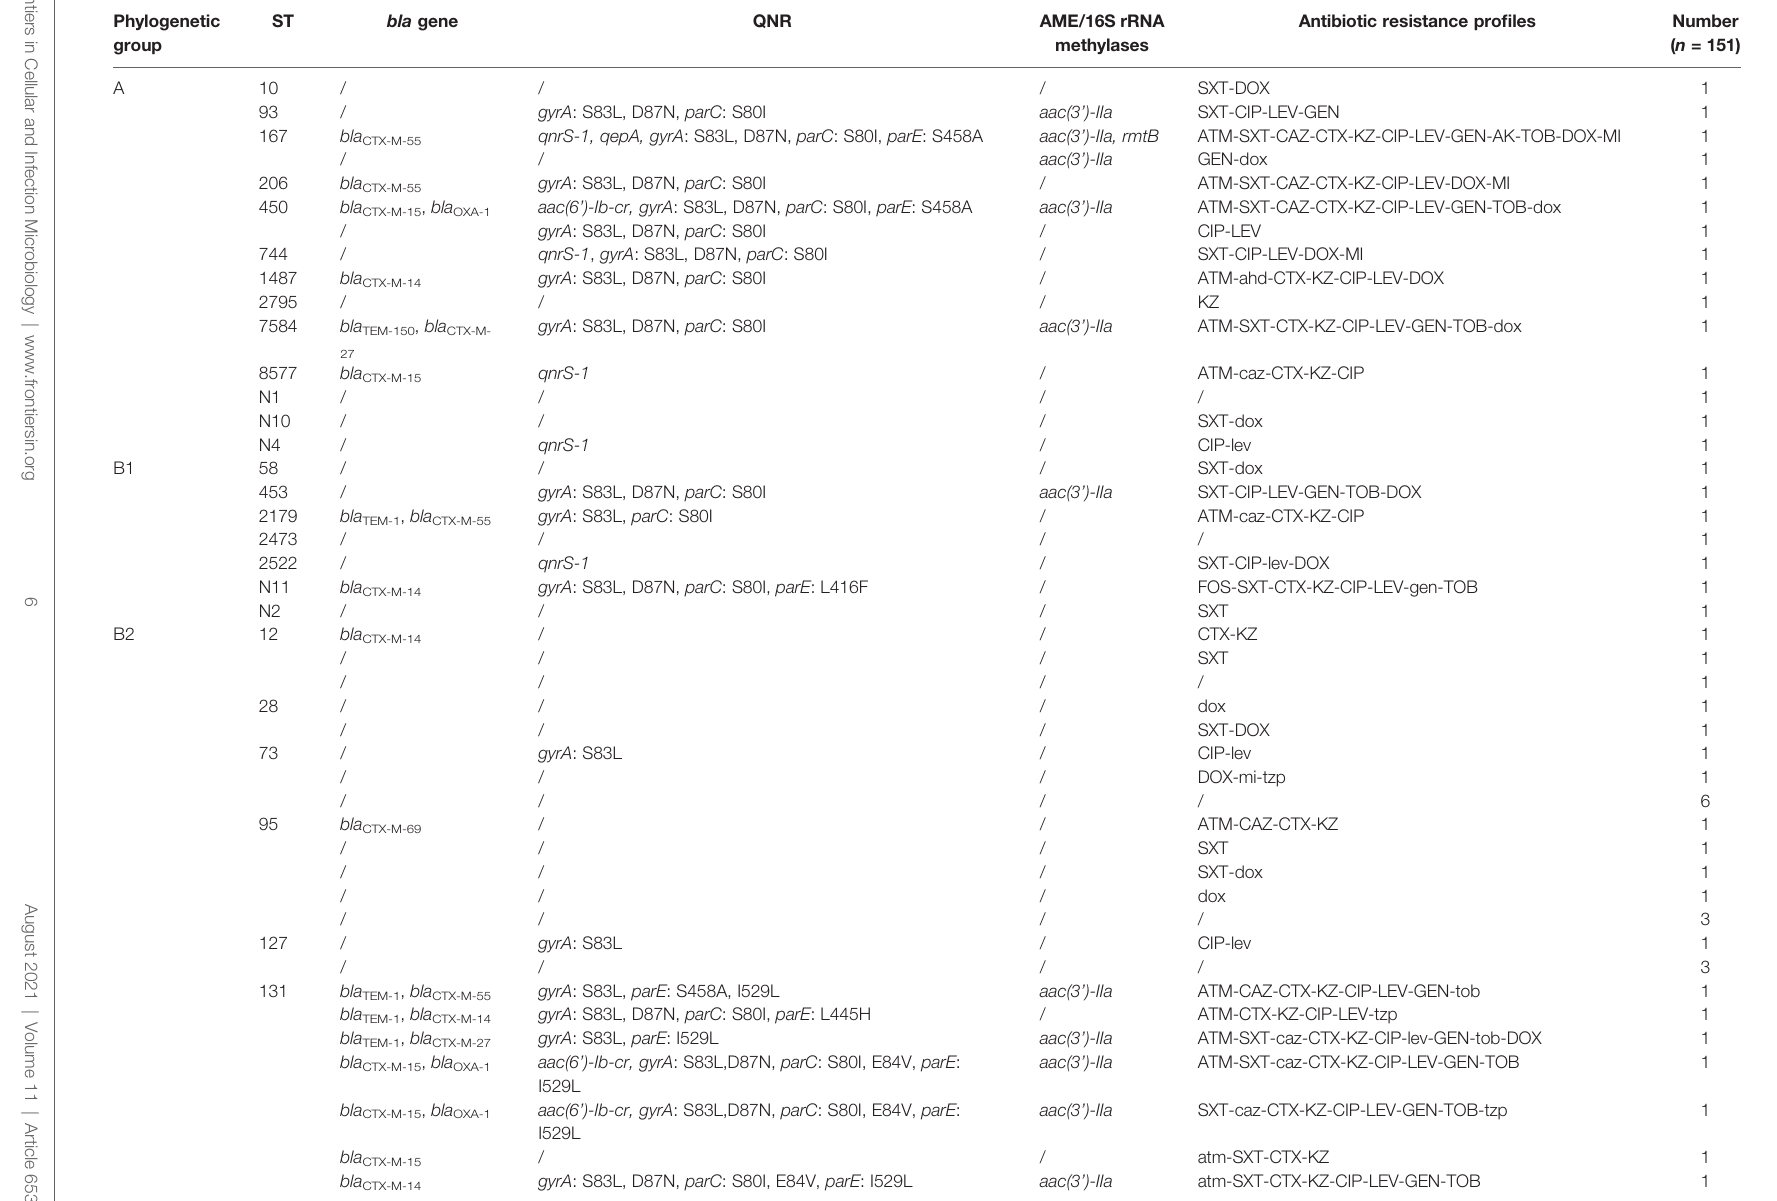
TABLE 2 | Prevalence of different resistance genes and their combinations with antibiotic resistance pro fi les in UPEC isolated from female patients. Phylogenetic